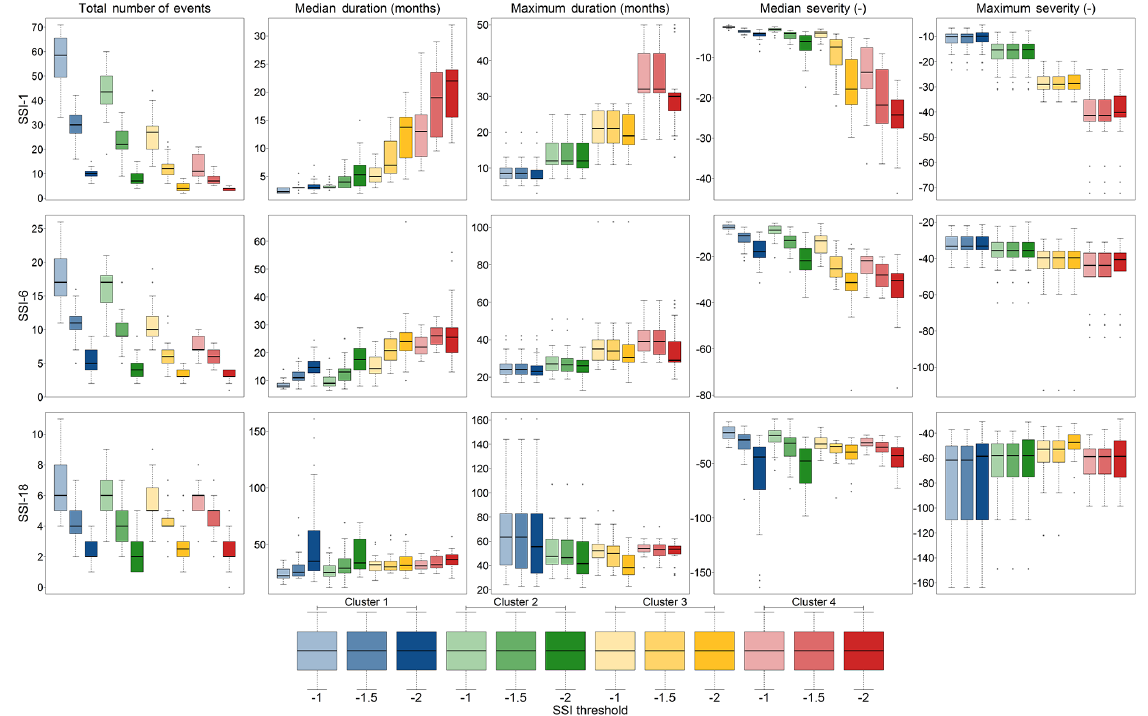
Figure 4. Boxplots showing hydrological drought characteristics based on SSI using thresholds of − 1, − 1.5 and − 2 for each cluster. Note that the y axis scale is different for each accumulation period to best show the full variability of the